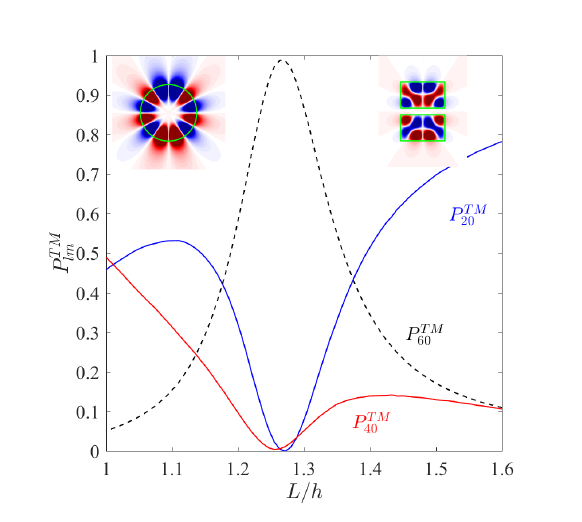
Figure 12. Evolution of the radiated power from two disks vs the distance between disks for the case shown in Figure 6 ( h = 1.038 a